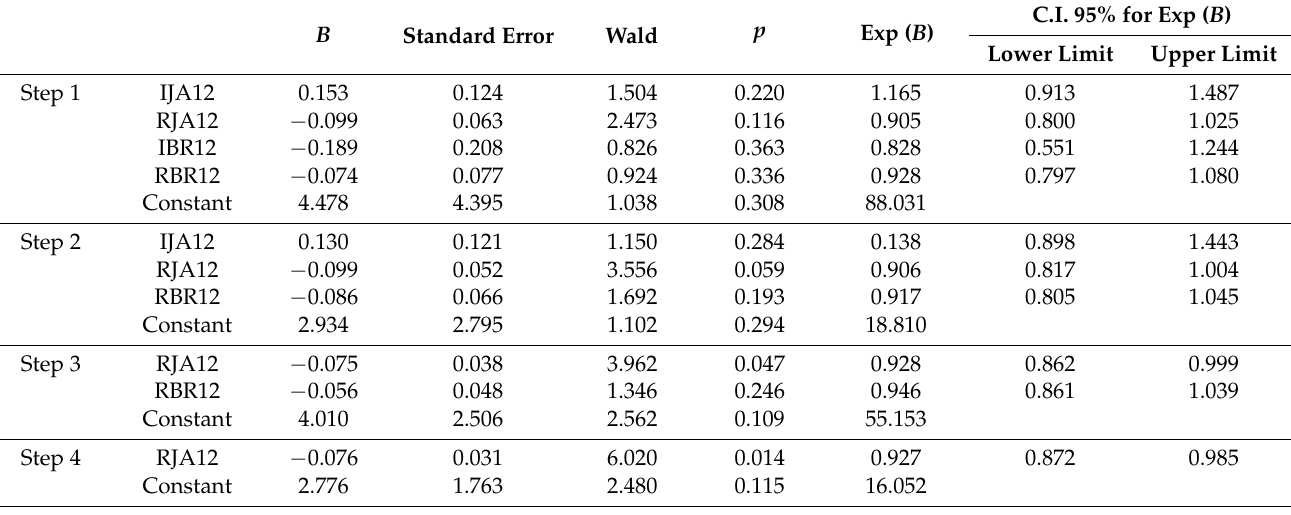
Table 4. Results for multiple logistic regression analysis (12